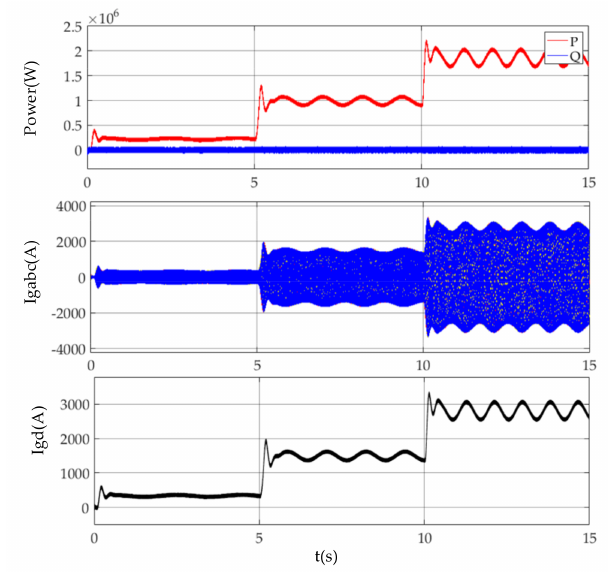
Figure 11. Waveform of grid connection point power and